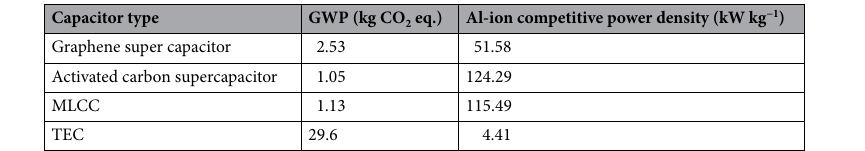
Table 4. Competitive functional power density for a variety of